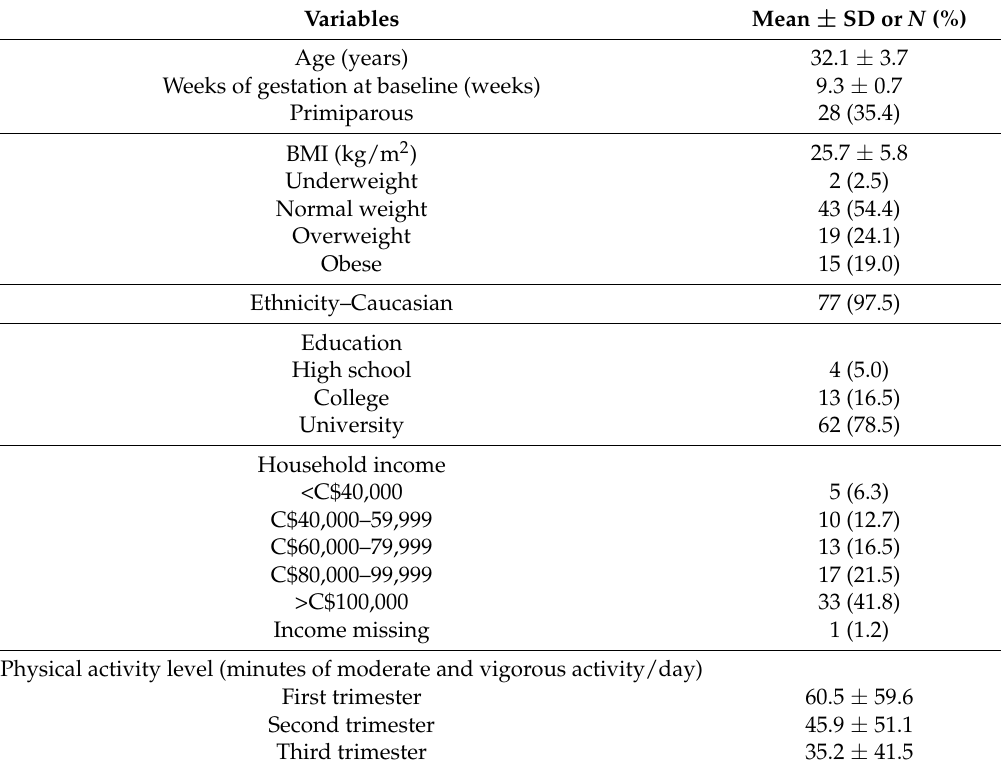
Table 1. Participants’ characteristics ( n =